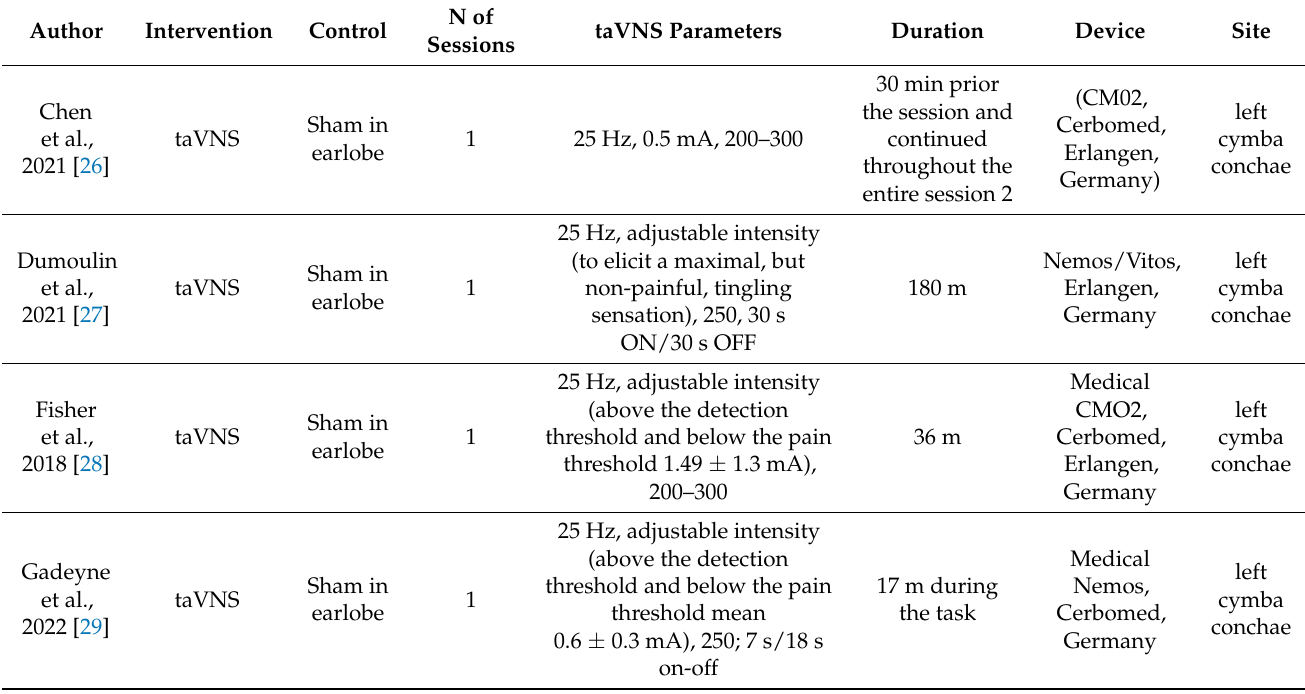
Table 2. Description of stimulation